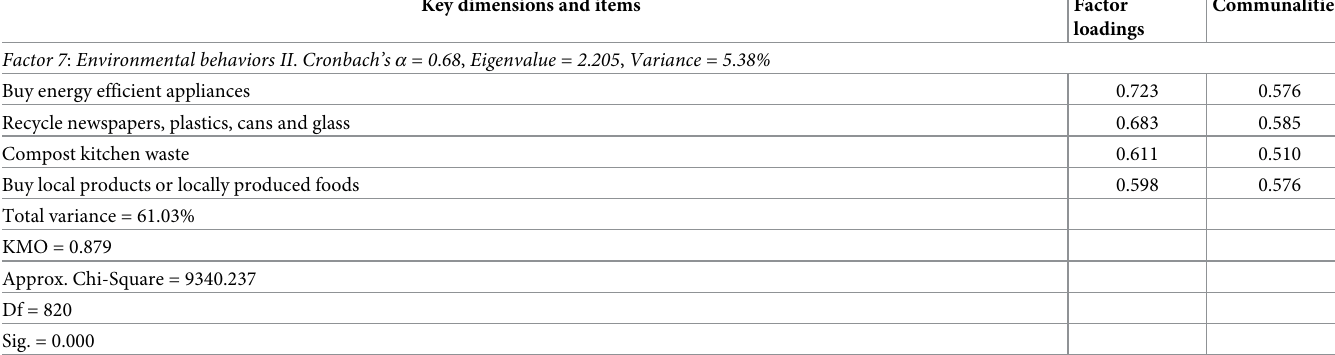
centred to reduce multicollinearity [134]. Tables 6 and 7 indicate that some of the control variables (gender, age) were significant pre- dictors, and accounted for 7% of variance in moral identity ( β = 4.41, P = 0.000), 3% of vari- ance in social judgement ( β = 4.41, P = 0.000), 2% of variance in environmental judgement ( β